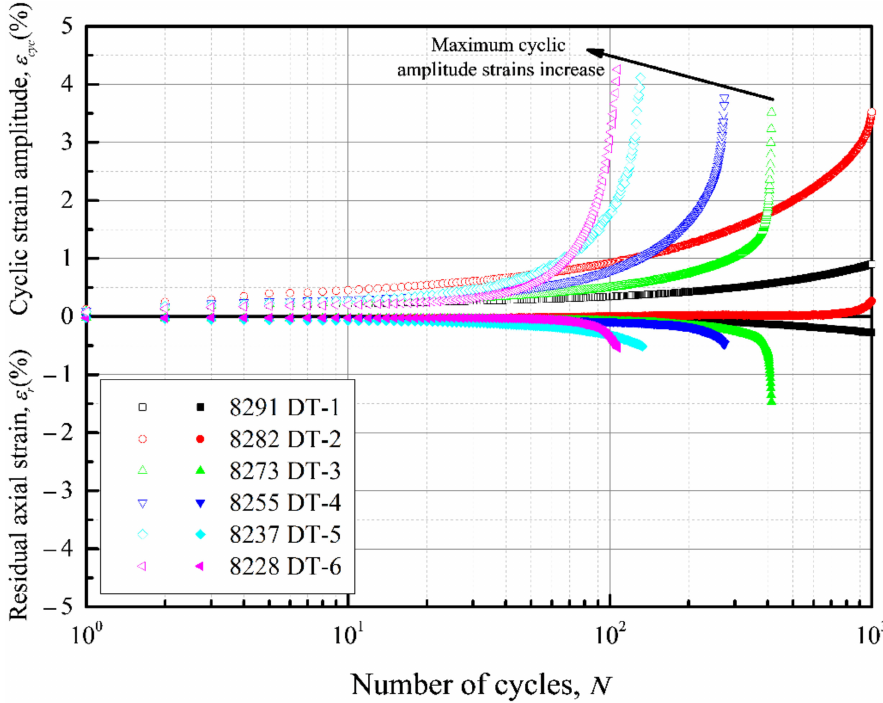
Figure 8. Relationship between number of cycles versus cyclic axial strain amplitude and residual axial strain for artificial marine